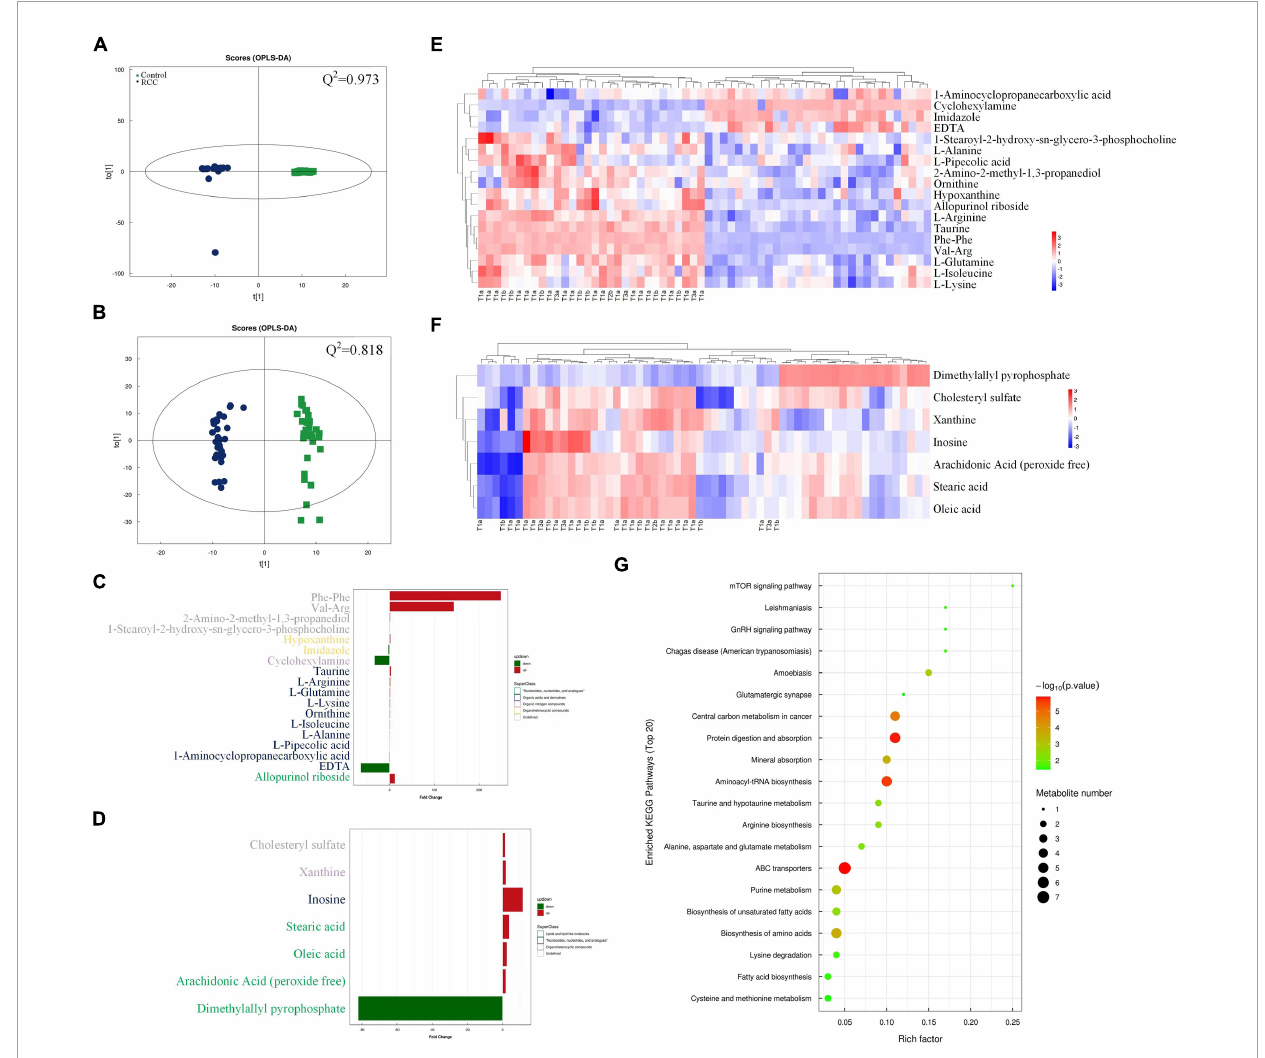
FIGURE2 Serum metabolomics profiles of the RCC and Control groups were explored and visualized. Score plot of OPLS-DA in positive (A) and negative (B) ion mode, Q 2 indicates the prediction ability of the model. Altered serum metabolites of ccRCC patients according to metabolomics analysis based on superclass in positive (C) and negative (D) ion mode. Abundance distribution of serum metabolites between the two groups analyzed by OPLS-DA and visualized by heatmaps in positive (E) and negative (F) ion mode, respectively. Each person in RCC group was marked with pathological grade. (G) Metabolic pathway impact map related to identified serum metabolites extracted from KEGG